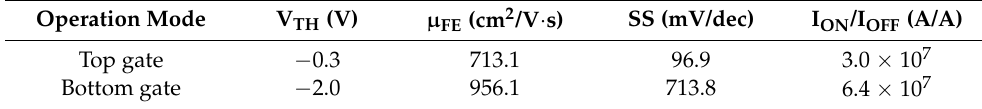
Table 1. Electrical parameters of the SiNW channel DG FETs during top and bottom gate operations.